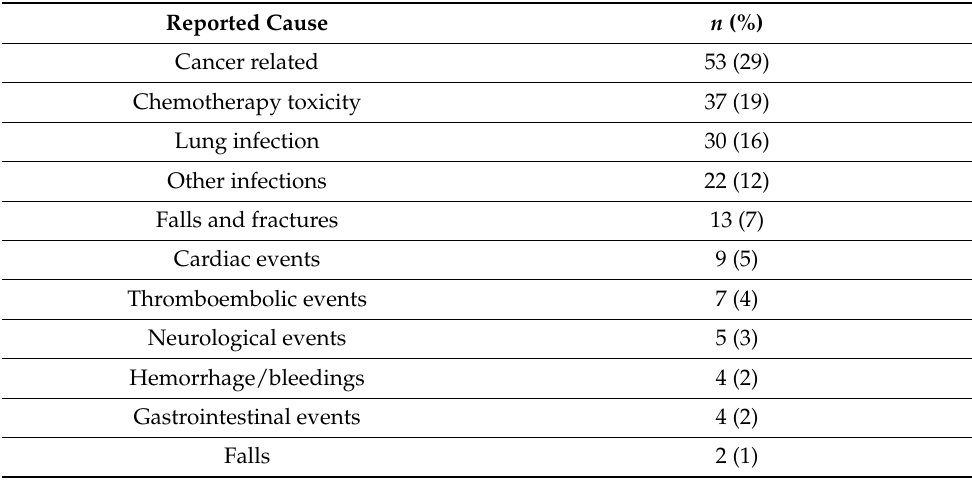
Figure 1. Percentage of unplanned hospitalizations by month. Table 2. Reasons for the first unplanned hospitalization in older patients with cancer treated with chemotherapy ( n =